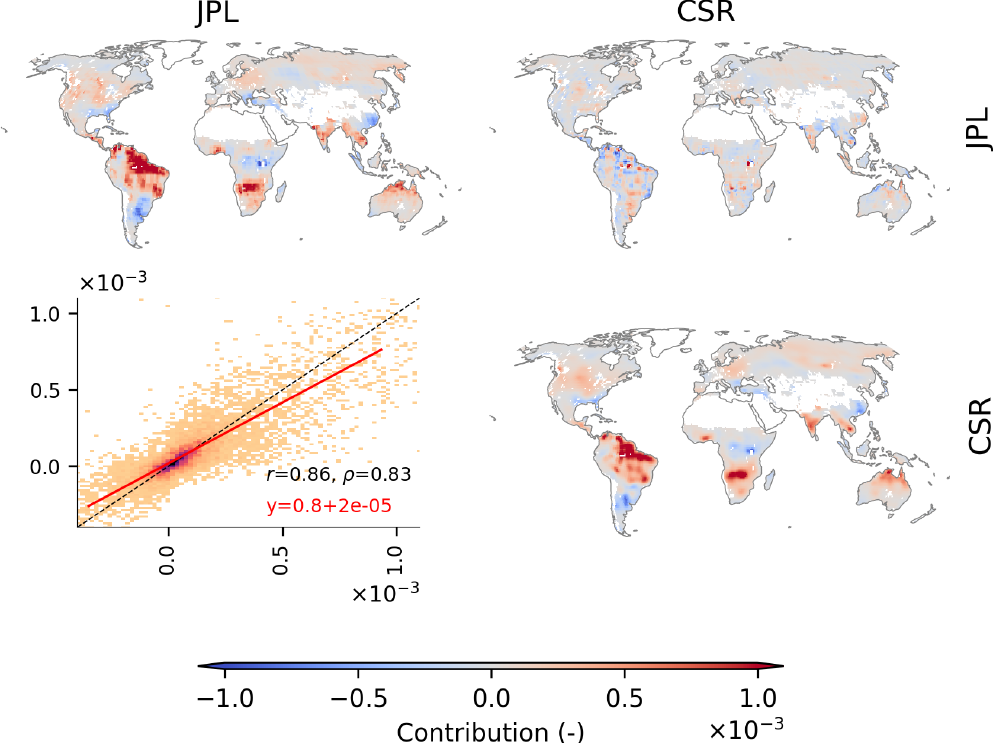
Figure B18. Same as Fig. 3 but for two GRACE mascon products by the Jet Propulsion Laboratory (JPL) and the Center for Space Re- search (CSR).